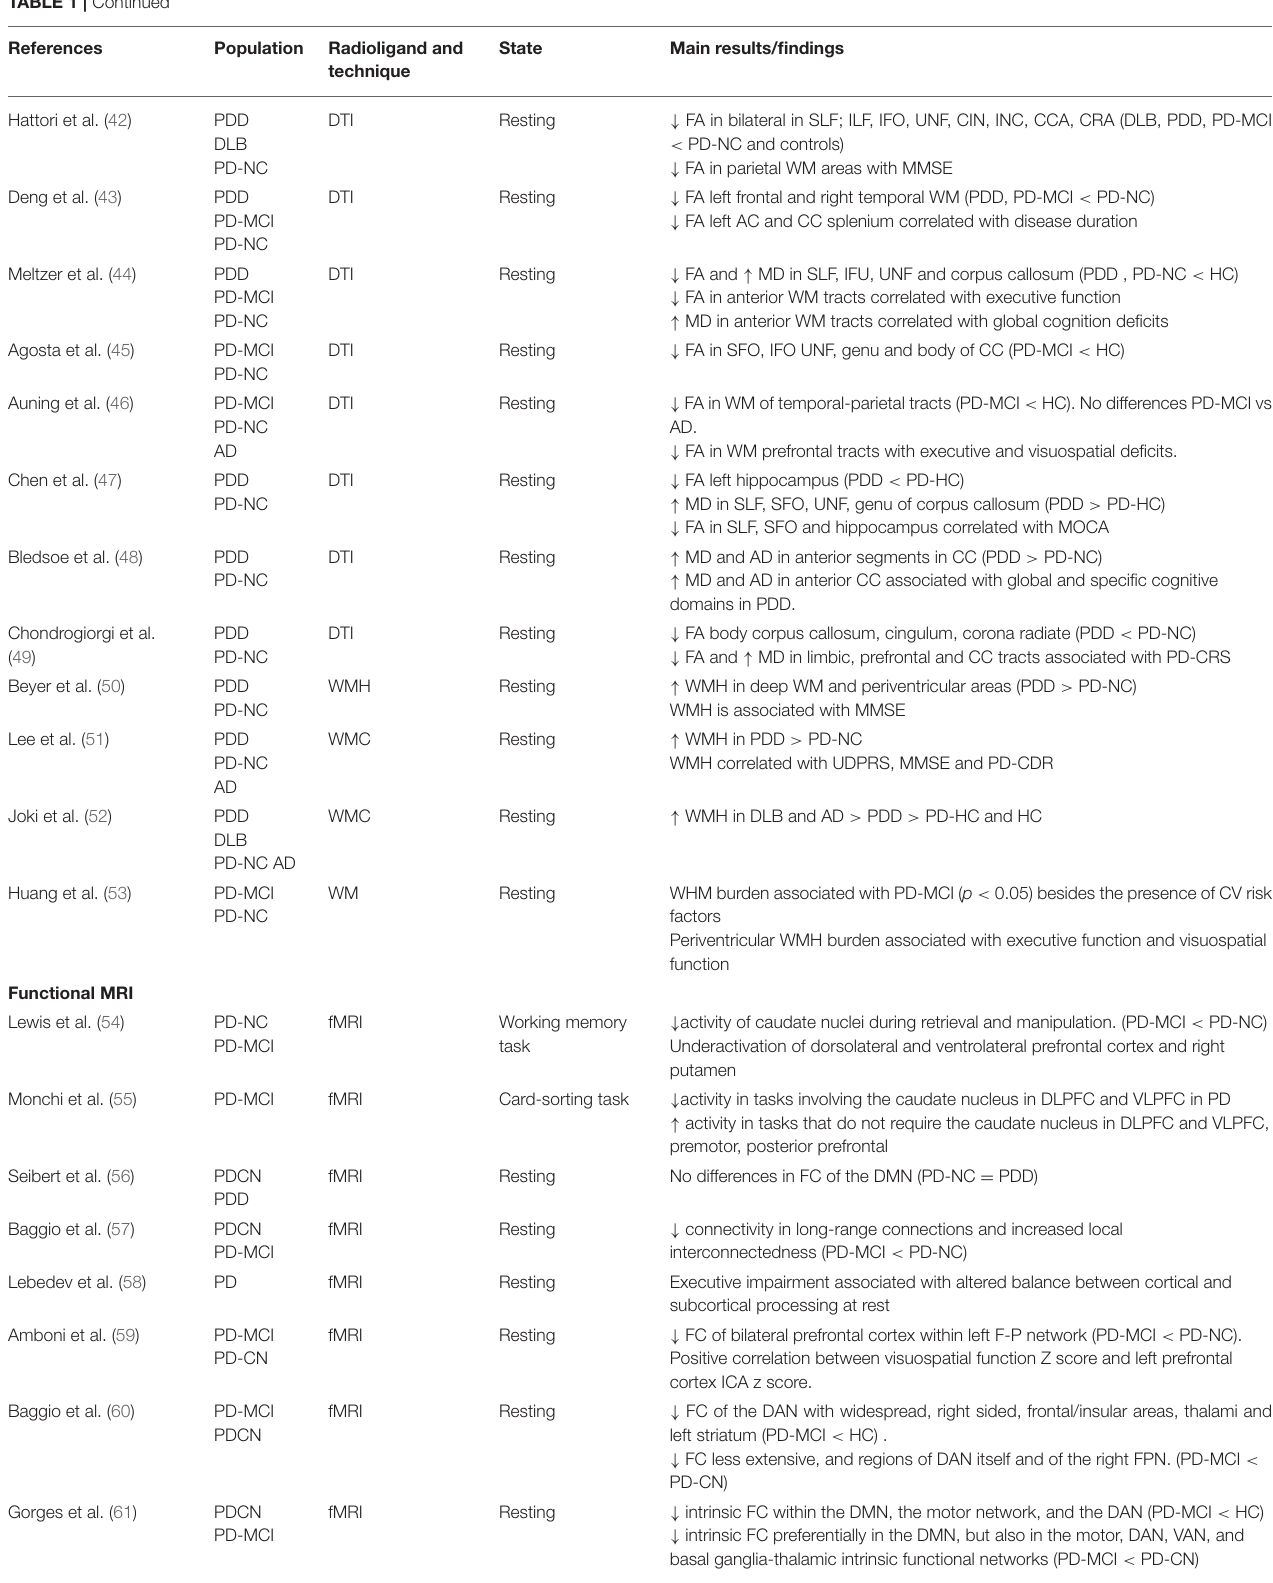
cortex ICA z score. Resting ↓ FC of the DAN with widespread, right sided, frontal/insular areas, thalami and left striatum (PD-MCI < HC) . ↓ FC less extensive, and regions of DAN itself and of the right FPN. (PD-MCI < PD-CN) Resting ↓ intrinsic FC within the DMN, the motor network, and the DAN (PD-MCI < HC) ↓ intrinsic FC preferentially in the DMN, but also in the motor, DAN, VAN, and basal ganglia-thalamic intrinsic functional networks (PD-MCI <